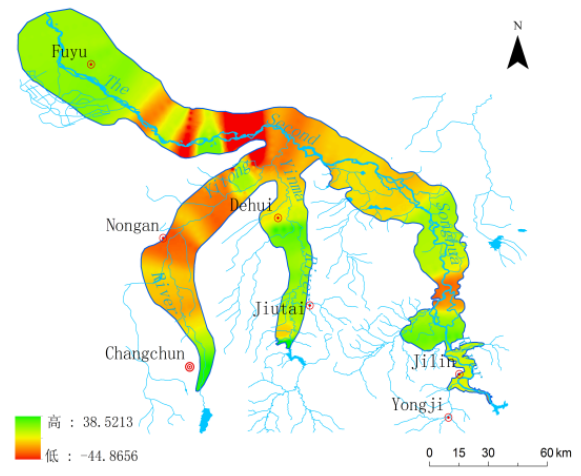
Figure 14. Distribution of hydraulic gradient.